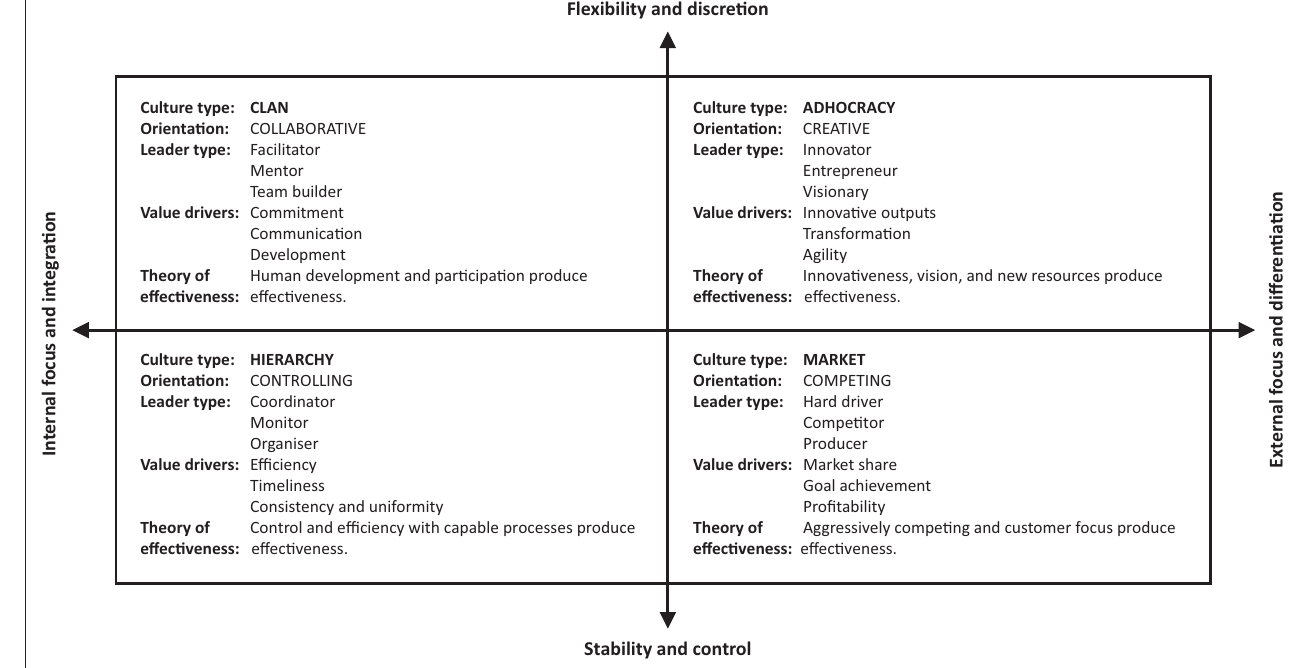
Flexibility and discre(cid:16)on